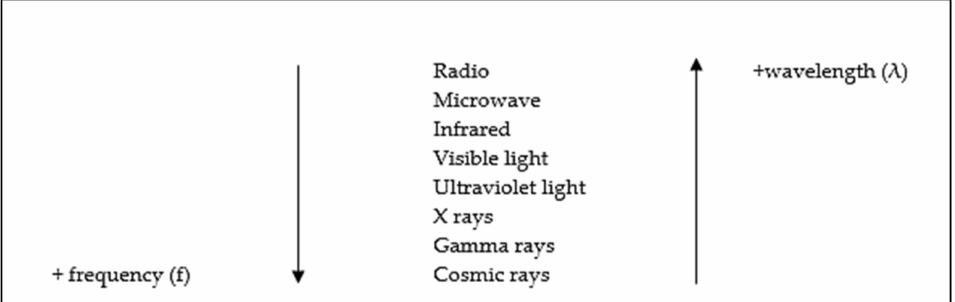
Figure 1. Types of electromagnetic radiation waves that form the electromagnetic spectrum